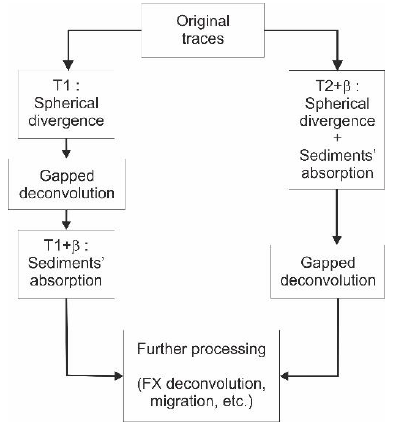
Figure 7. Two possible strategies for multiples’ attenuation: one step only (right), when the decon- volution follows the full gain recovery; and two steps (left), when the deconvolution follows the spherical divergence correction, which enhances the multiples, but precedes the gain compensation for the absorption based on the spectrum shape of the seismic traces.